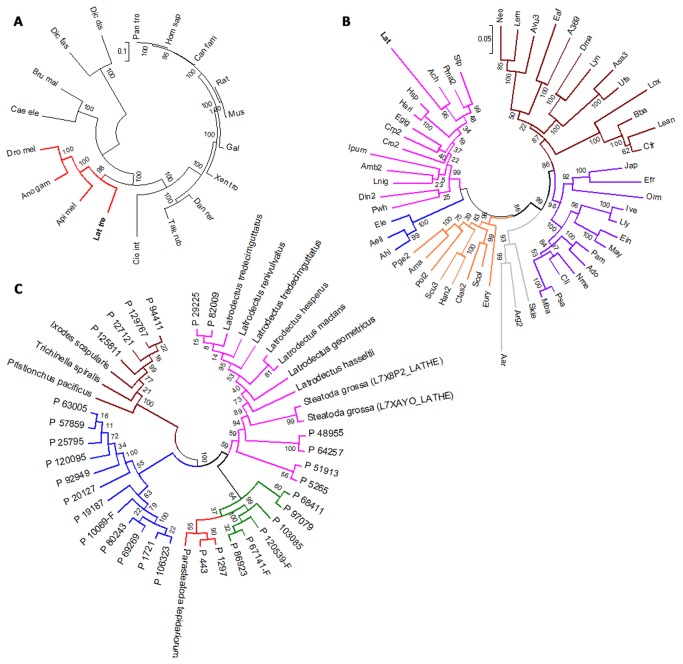
Evolutional relationship of species and toxins.A. Phylogenetic tree of the 26 species. It was constructed by MAGE software using sequences of single-copy nuclear protein-coding genes from these species. Latrodectus
tredecimguttatus was grouped with other arthropods (insects) and highlighted in red. B. Phylogenies of Arthropod. Latrodectus
tredecimguttatus was clustered with other three spider species (Theraphosidae, Amblypygi and Schizomidae) in Arachnida, which are marked with different colors: purple, Hexapoda; brown, Crustacea; silver gray, Oligostraca; orange, Myriapoda; blue, Pycnogonida; The full names of the species can be found in Tables S7 and S8 File S1. C. Phylogenies of the ANK superfamily, in which pink indicates α-LTX-Lt1a family1; blue indicates α-LTX-Lt1a family2; green indicates δ-LIT-Lt1a family; red indicates α-LIT-Lt1a family; brown indicates ANK family.